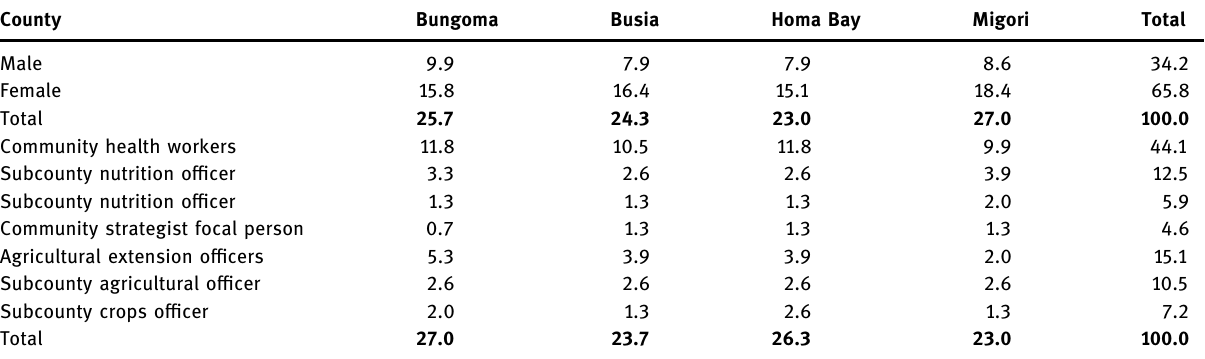
Table 1: Actors on the WhatsApp platform per county County Bungoma